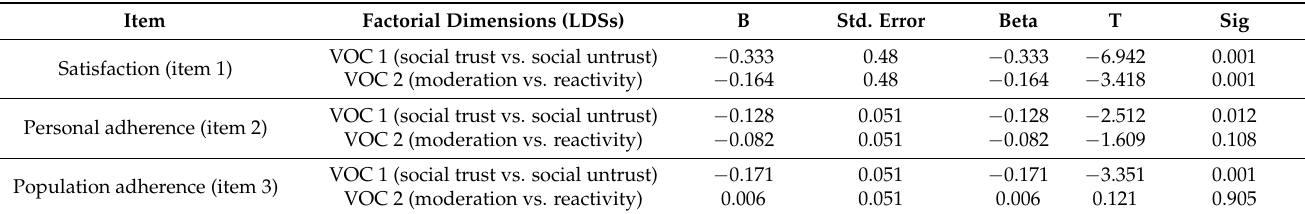
Table 3. Regression models